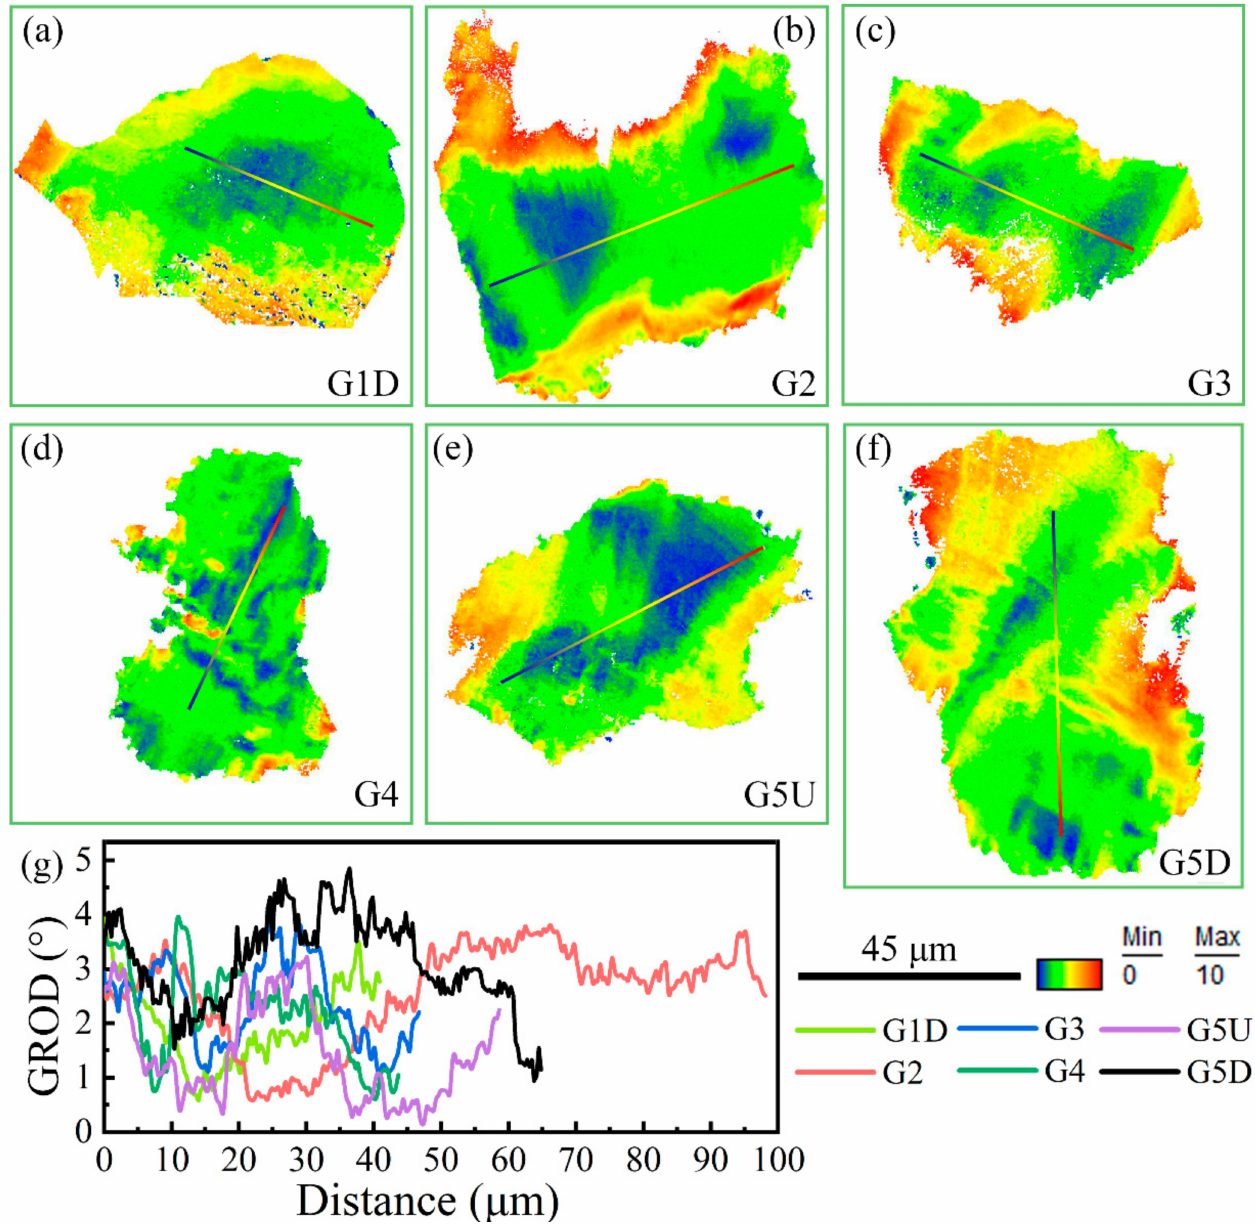
Figure 10. The maps of grain reference (referred to grain average orientation) orientation deviation (GROD) for several grains in Figure 8 at 15% global strain ( a – f ), and the orientation deviation profile along specific lines in the interior of the grain ( g